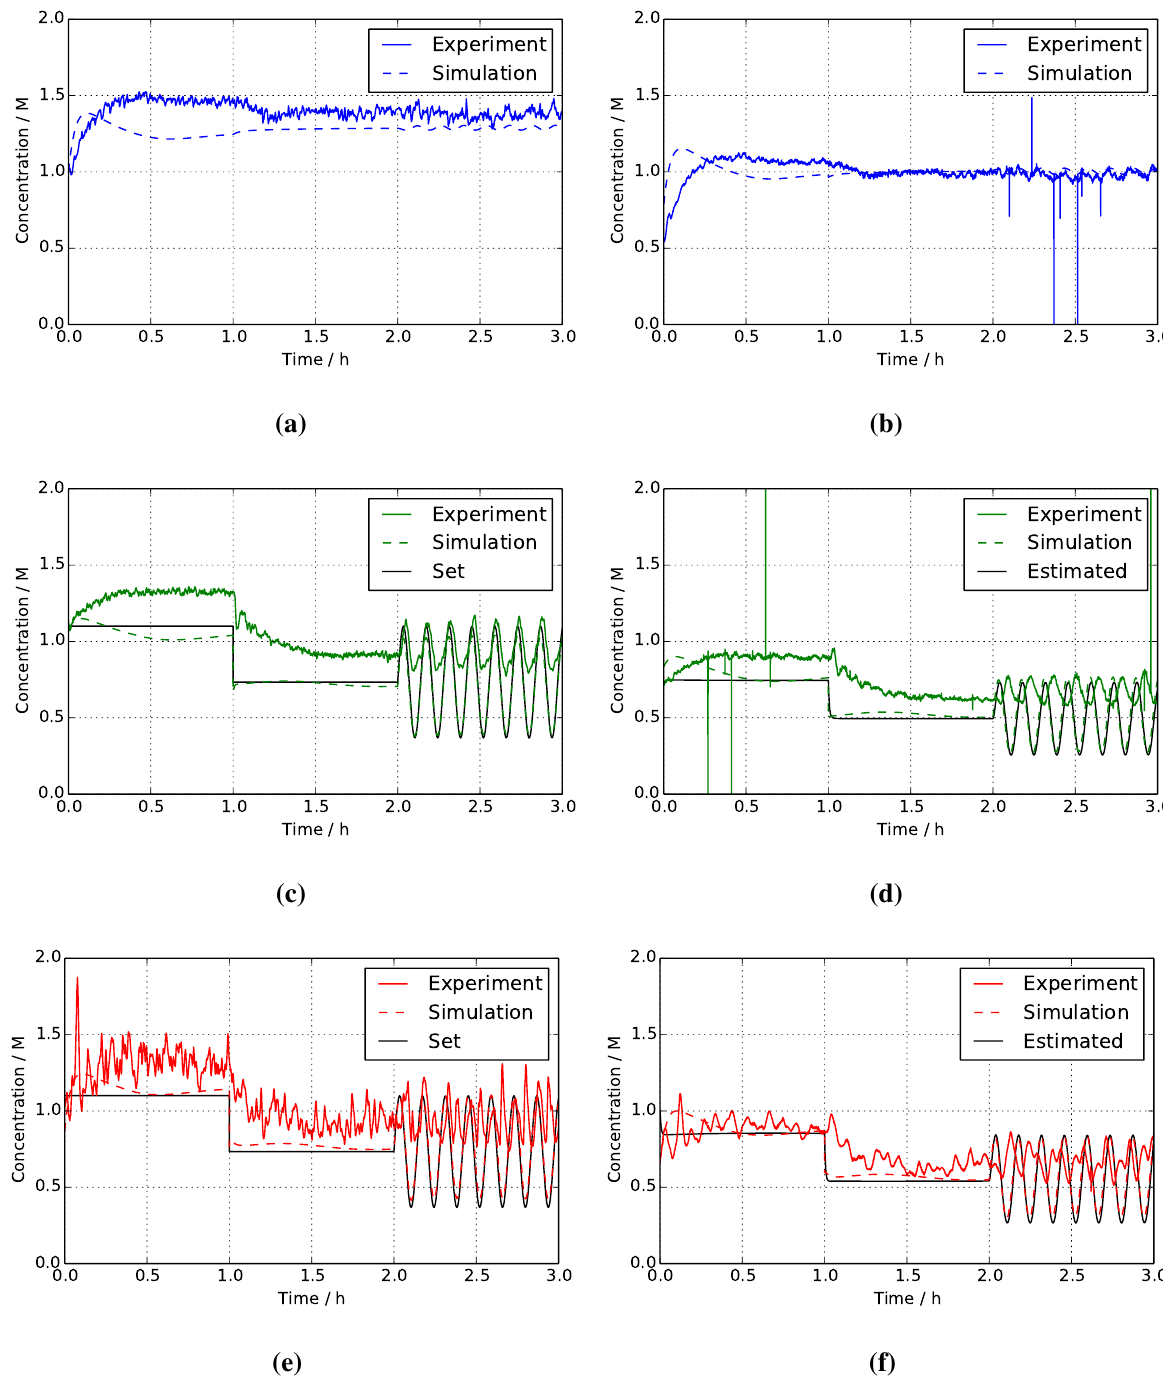
Figure 9. Stack inlet and outlet concentrations for all systems: ( a ) reference, inlet; ( b ) reference, outlet; ( c ) two-mixer, inlet; ( d ) two-mixer, outlet; ( e ) separate tanks, inlet; and ( f ) separate tanks,